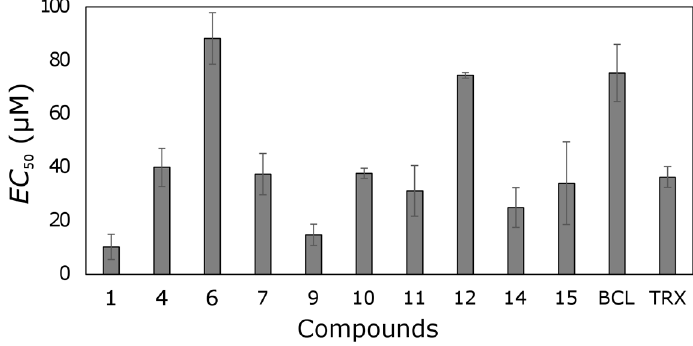
Figure 6. The antioxidant activity of trihydroxyflavones and TRX.